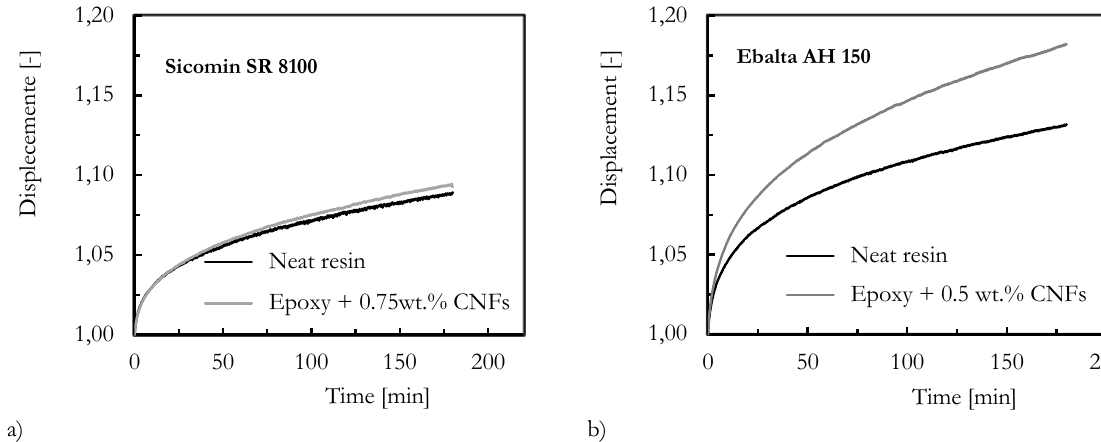
Figure 8: Creep curves for: a) Neat Sicomin SR 8100 and nano-enhanced resin with 0.75 wt.% CNFs, at bending stress of 50 MPa, b) Neat Ebalta AH 150 and nano-enhanced resin with 0.5 wt.% CNFs, at bending stress of 50